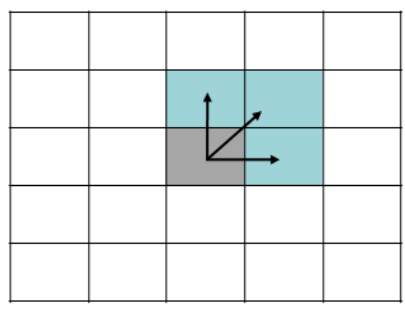
Figure 2. Neighborhood propagation illustration.